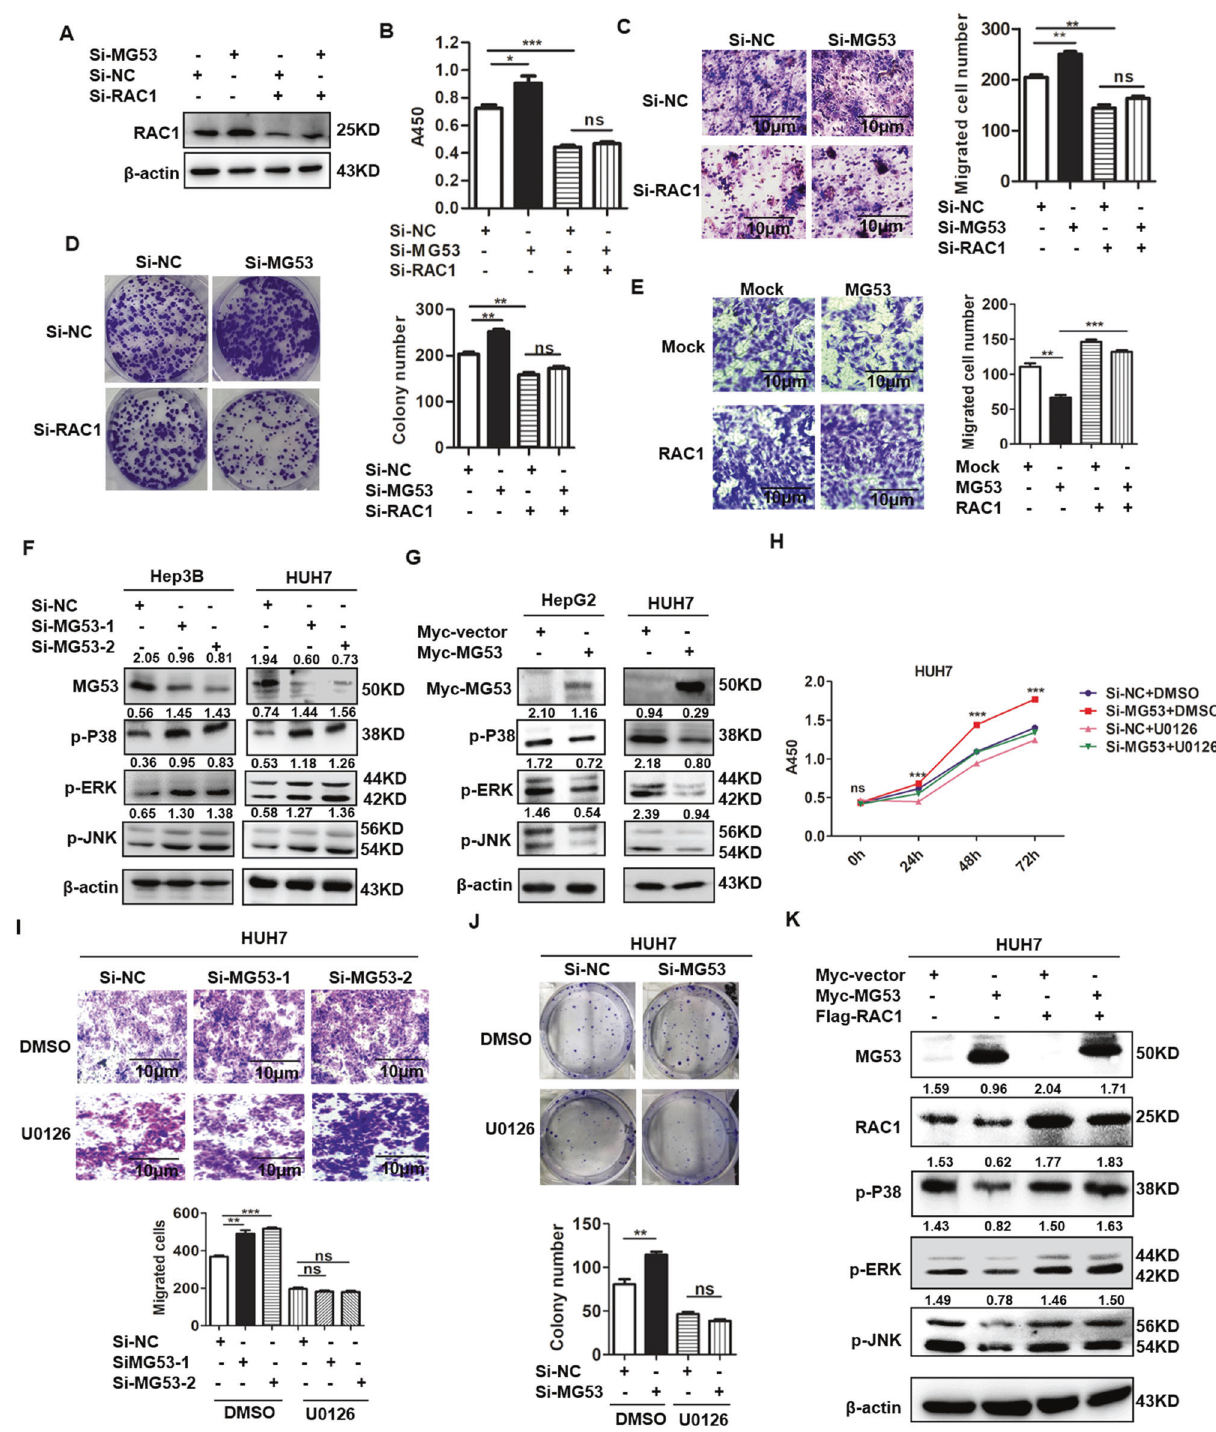
The RAC1 protein has been recognized as a central signaling hub that is required for many oncogenes induced transformation, and RAC1 propagates its downstream biological effects by activating its effector signaling pathways [7, 41]. Though RAC1 was reported to be regulated by multiple proteins, the negative regulation of RAC1 activity by MG53 in HCC was reported here for the fi rst time. Here we demonstrated that MG53 induced poly-ubiquitous degradation of RAC1 and further inhibited RAC1 and its downstream mitogen- activated protein kinase (MAPK) pathway. MAPK signaling